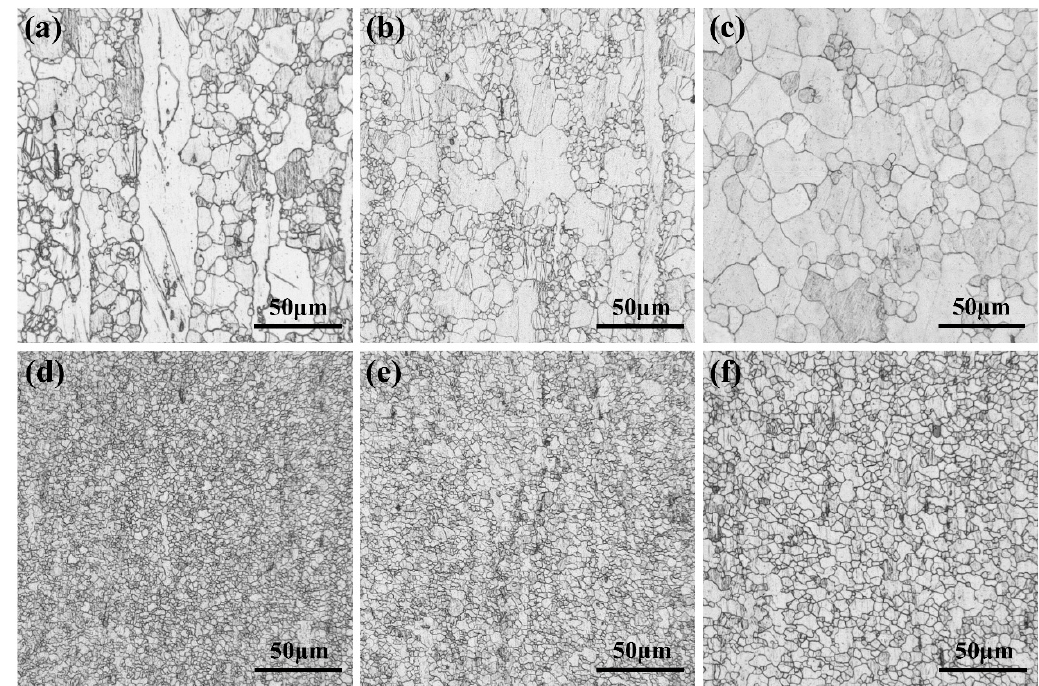
Figure 4. Metallographic microstructure of the extruded sheets prepared by low-speed extrusion at different temperatures: ( a , d ) 350 °C; ( b , e ) 400 °C; ( c , f ) 450 °C.